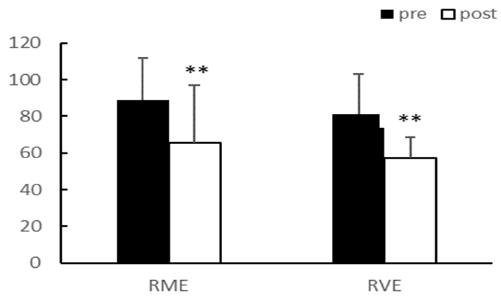
Figure 4. TG (mg/dL). TG, Triglyceride; ** p < 0.01.